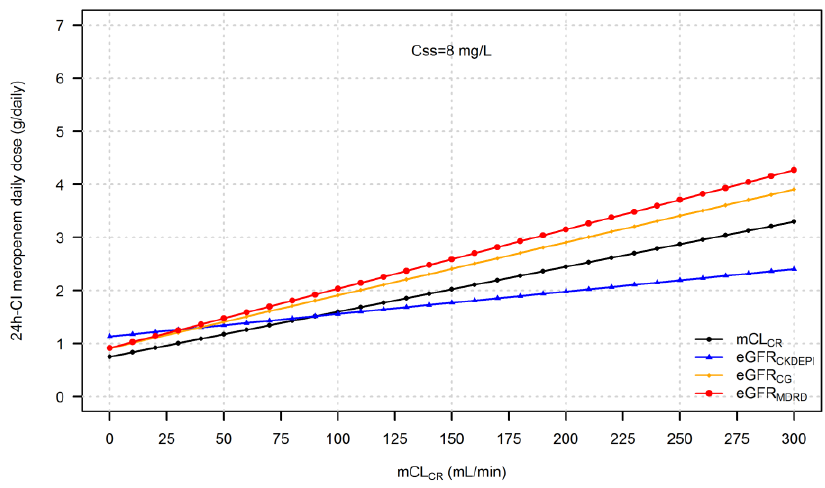
Figure 4. 24 h-CI meropenem daily dose necessary to achieve the targeted C ss of 8 mg/L by using eGFR CKDEPI , eGFR CG , or eGFR MDRD compared to mCL CR .